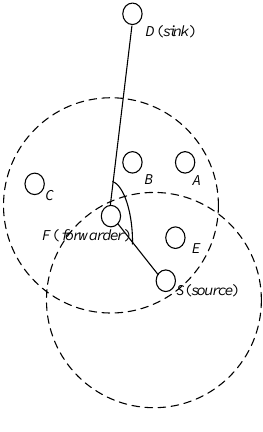
Figure 4. The principle of DFR.